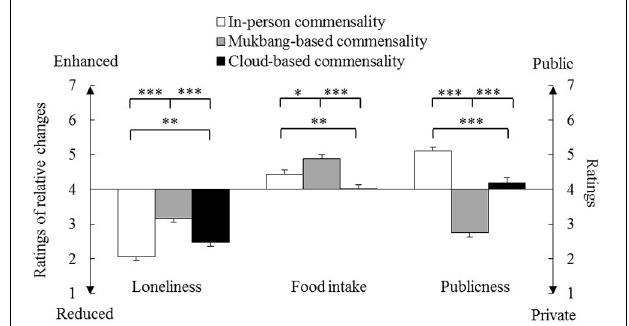
( M unhealthy = 5.4 ± 0.8 vs. M healthy = 4.6 ± 0.9), more